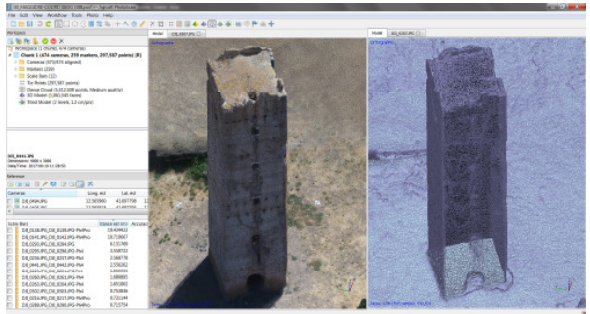
Figure 7. T. Maggiore. Final mesh, textured and wireframe